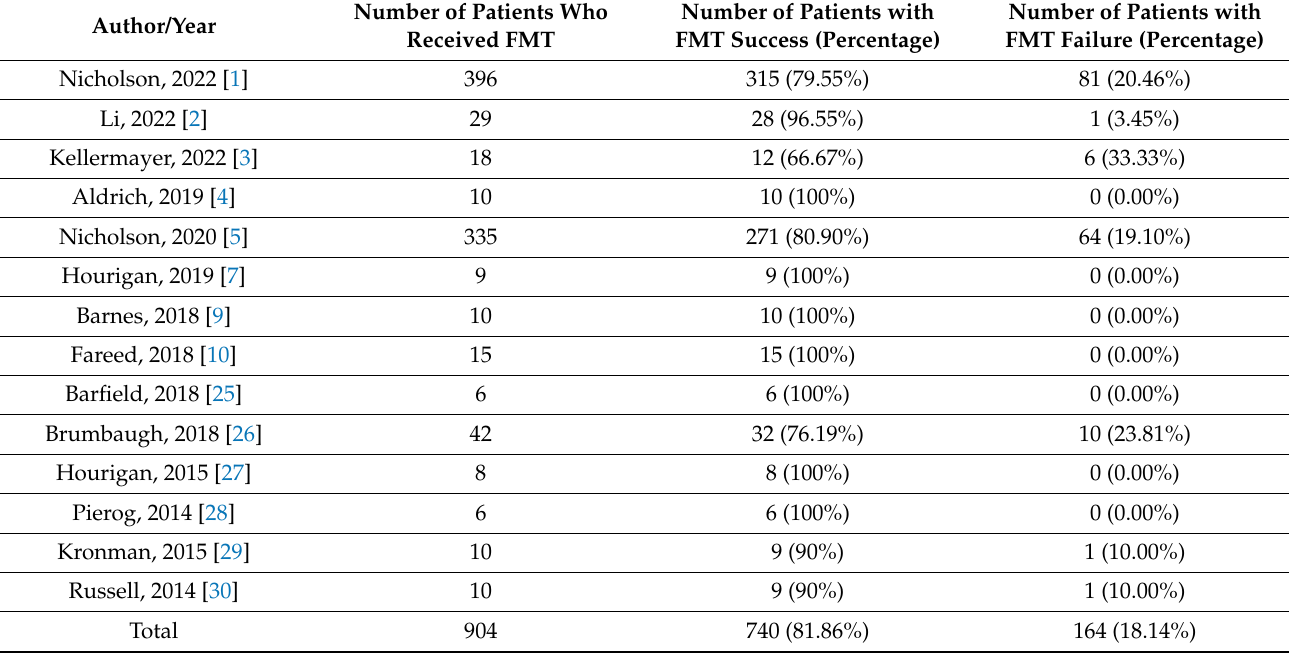
Table 4. Efficacy outcomes in the FMT